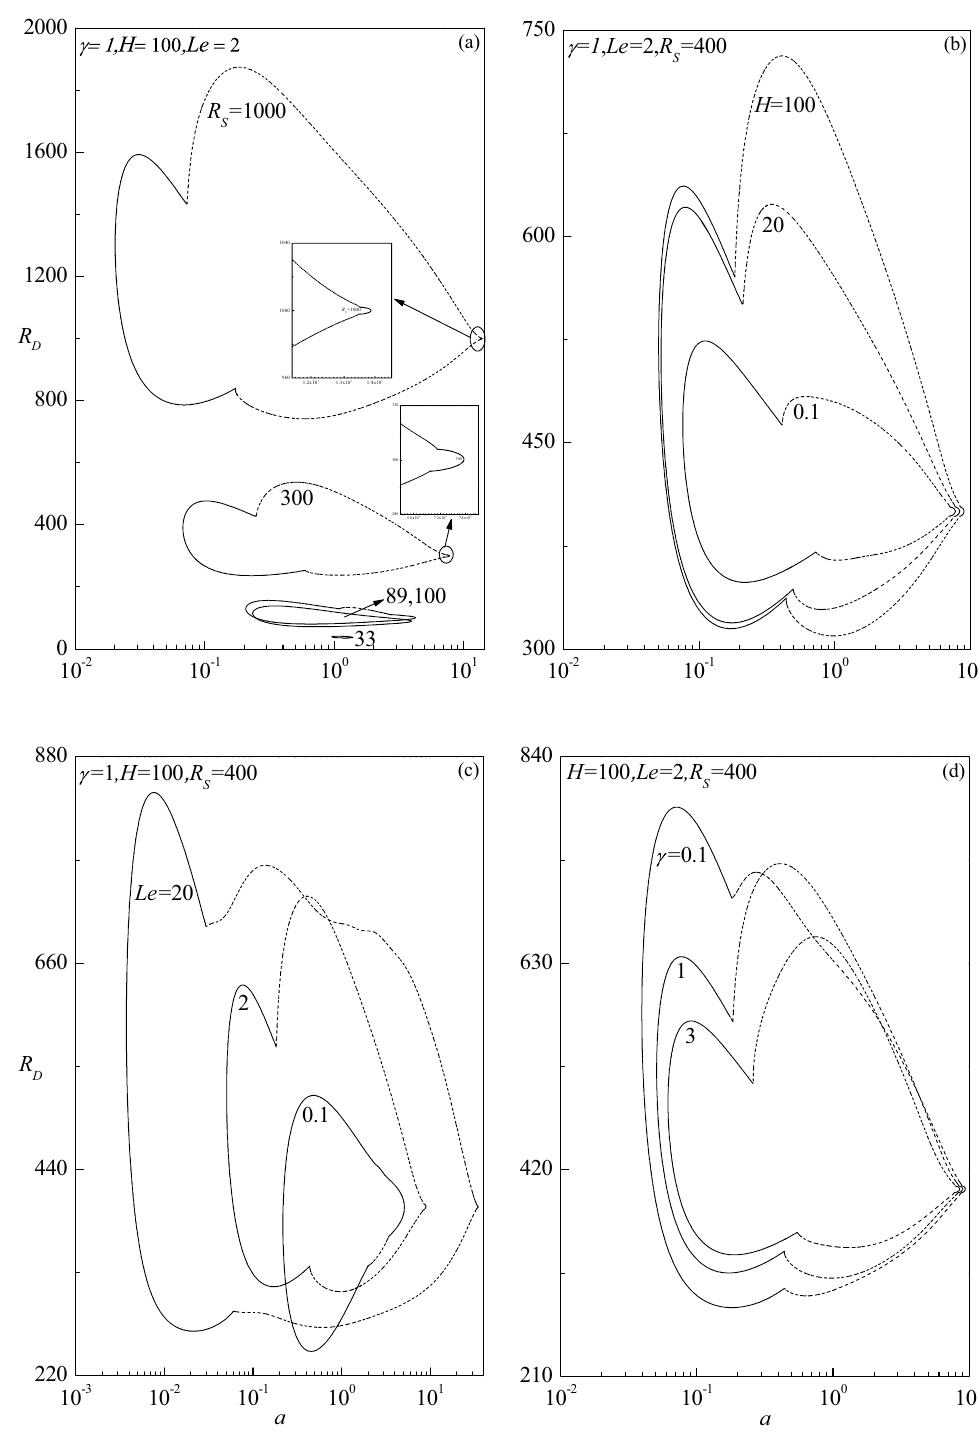
Figure 4. Evolution of neutral stability curves in the ( a , R D ) -plane for different values of ( a ) R S , ( b ) H , ( c ) Le and ( d ) γ . The solid and dashed lines respectively denote the stationary and travelling-wave modes. This convention applies to all the figures